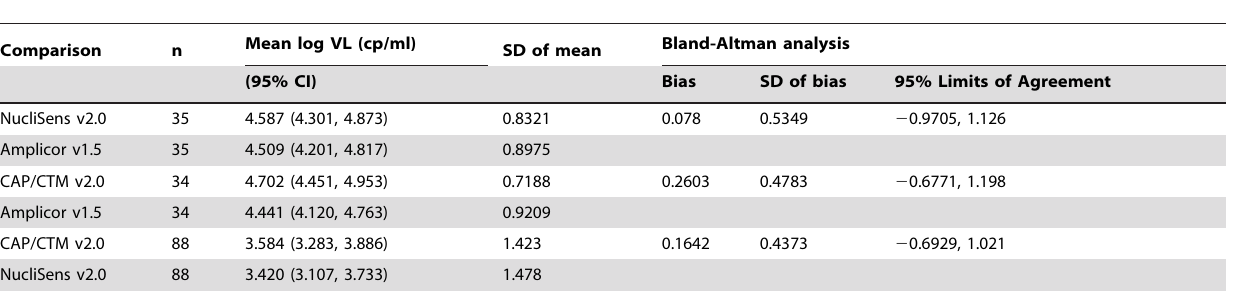
Table 1. Data summary for viral load results as determined by the Amplicor v1.5, NucliSens v2.0 and CAP/CTM v2.0 assay.